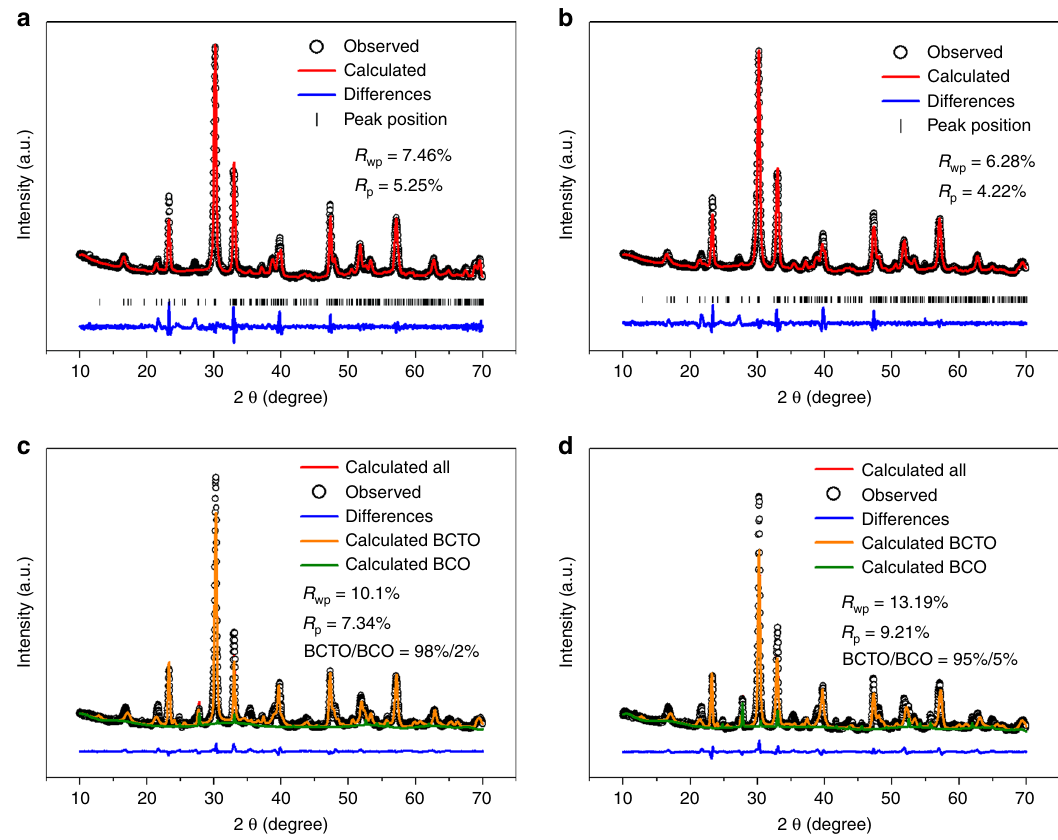
Fig. 1 XRD patterns and re fi nements for as-prepared samples. a Co1; b Co2; c Co3; and d Co4